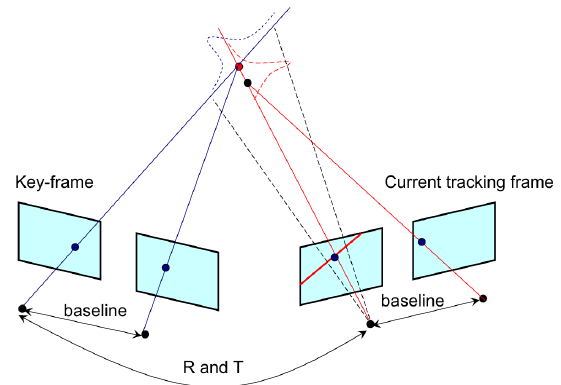
Figure 3. Multi-view observations by stereo. Between the two frames, the camera motions R and T provide a dynamic pseudo baseline, and for each stereo frame, the feature position is constrained by the static stereo